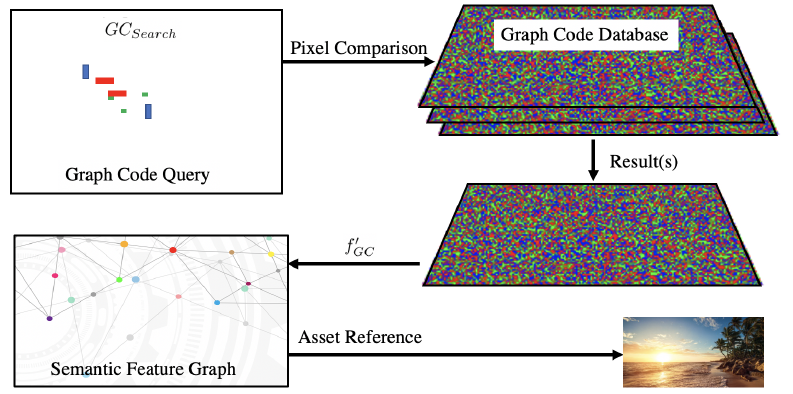
Figure 8. Graph-code-based querying and